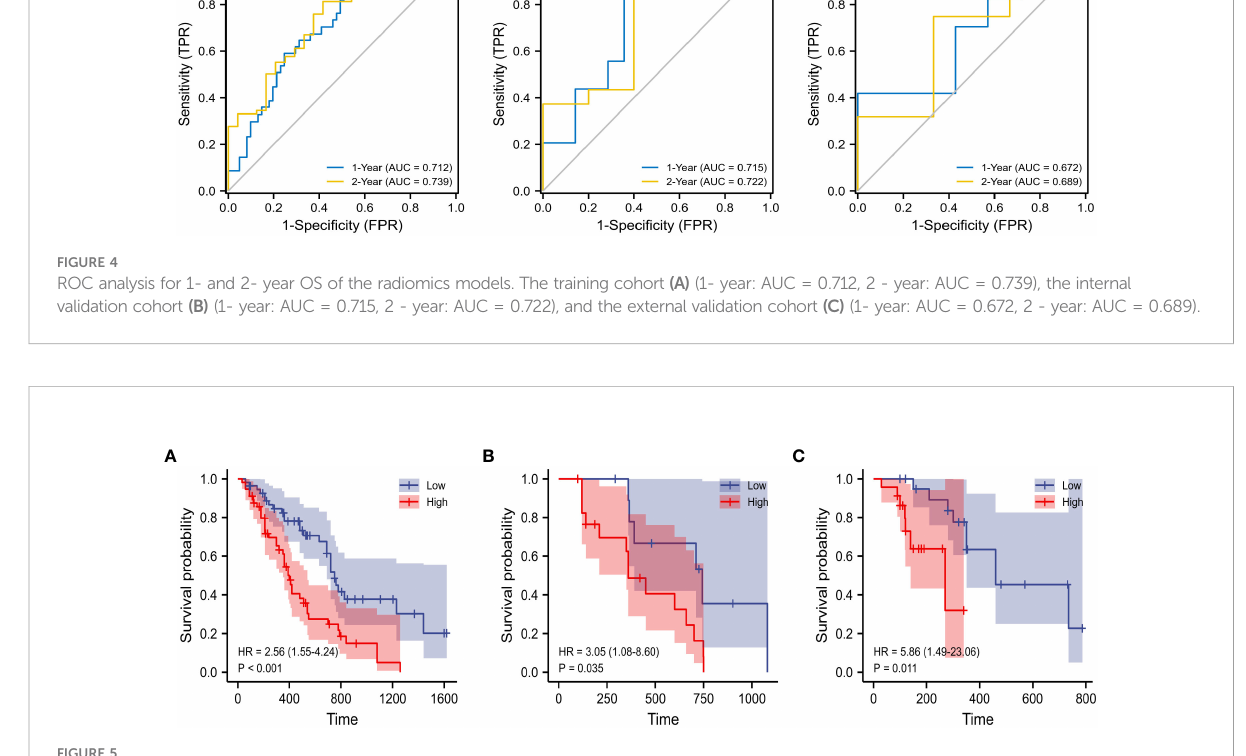
FIGURE 5 K – M analysis of Rad-score for overall survival in the training (A) , internal (B) and external validation cohorts (C)